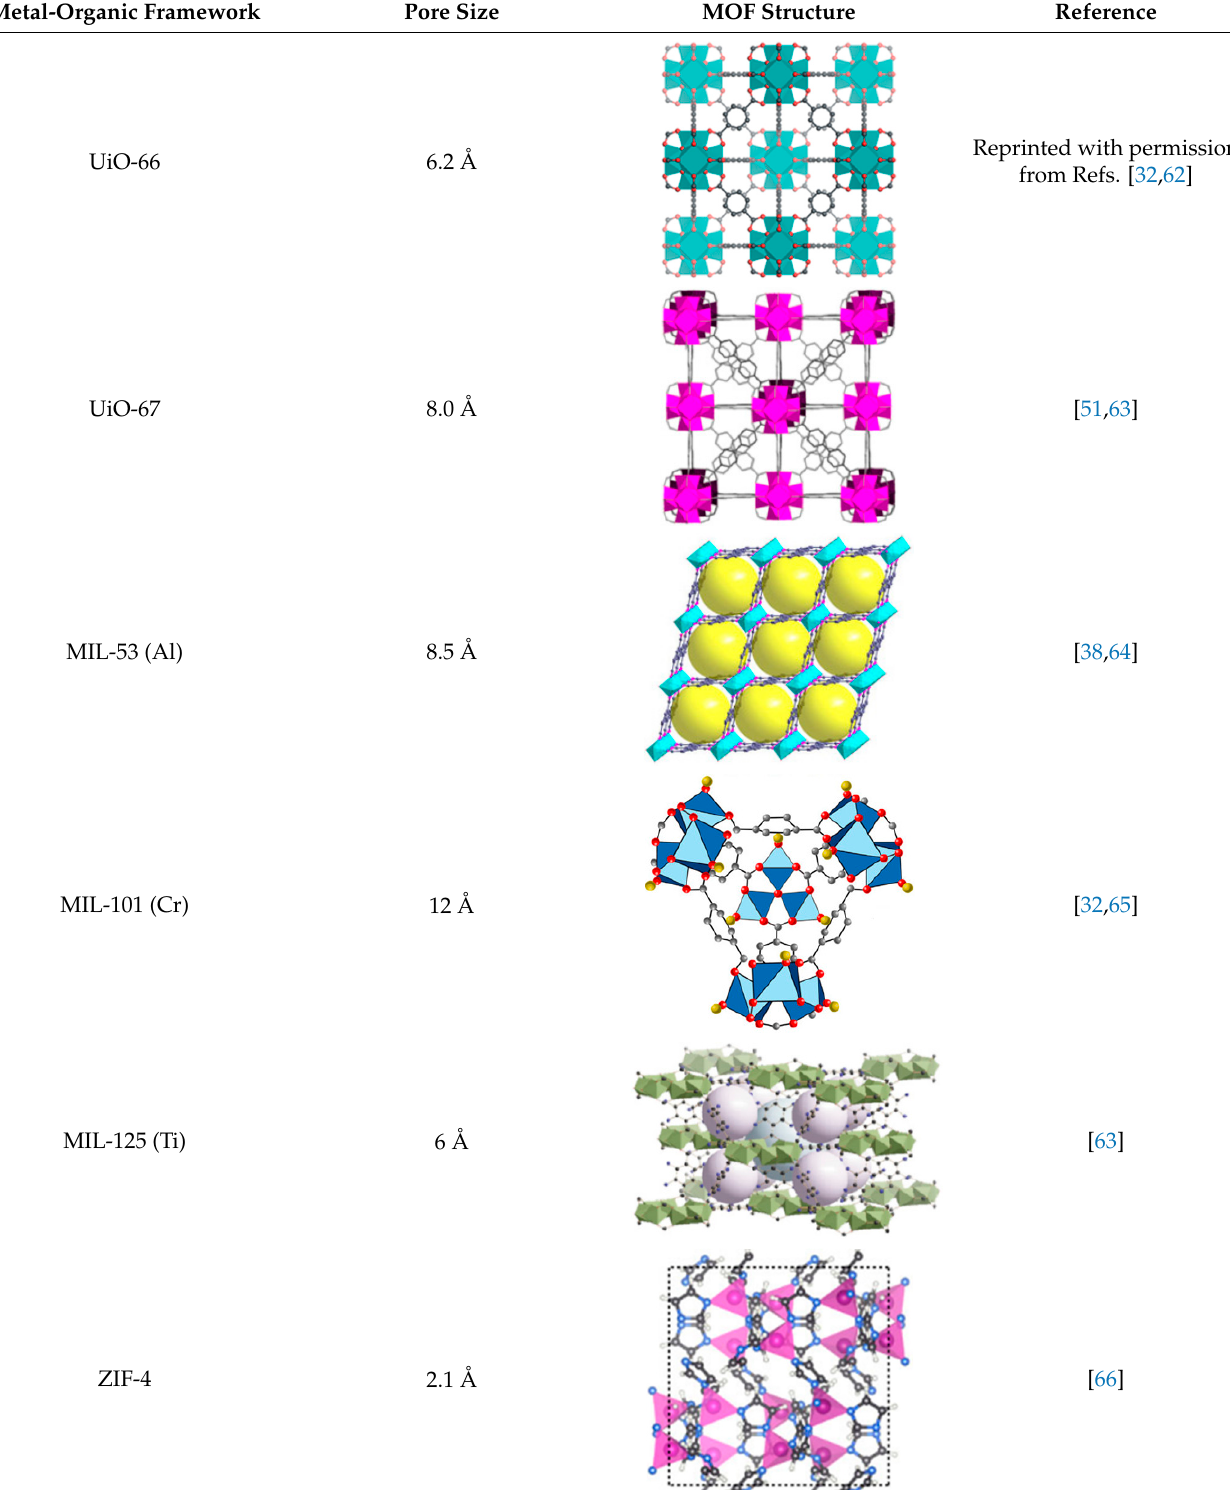
Table 1. Illustration of MOF Table 1. Illustration of MOF structures. Table 1. Illustration of MOF structures. Table 1. Illustration of MOF structures. Table 1. Illustration of MOF structures. Table 1. Illustration of MOF structures. Table 1. Illustration of MOF structures.